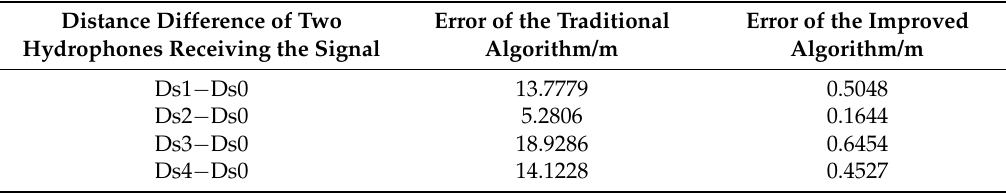
Table 4. Error comparison of the calculation values of the distance